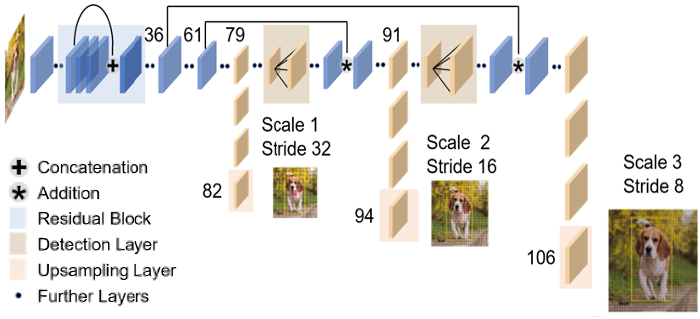
Figure 2. YOLOv3